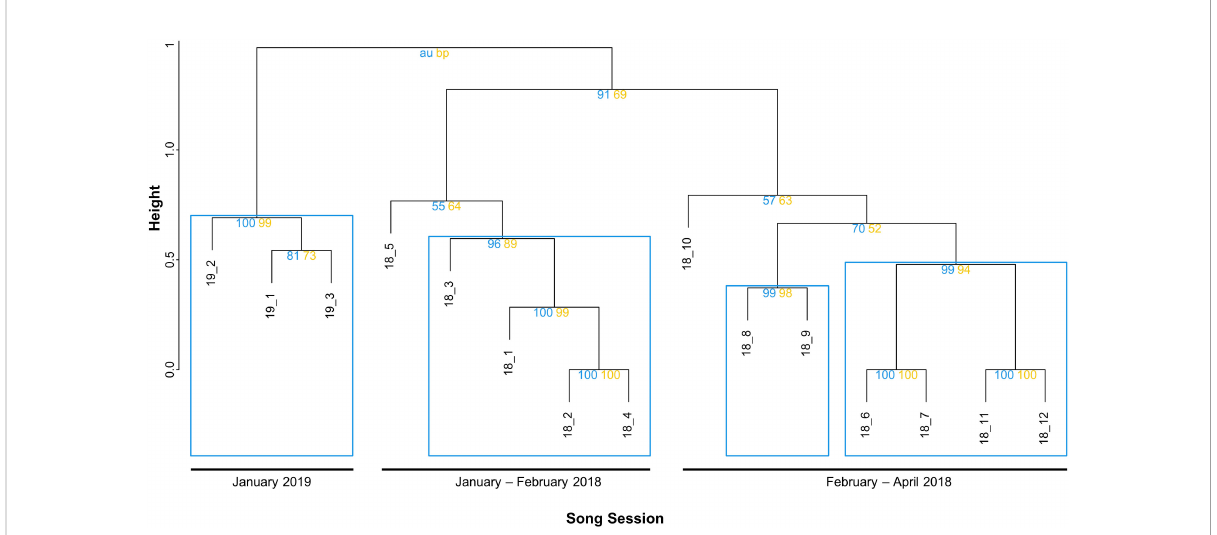
FIGURE 5 Dendrogram of bootstrapped (1000) LSI of average-linkage hierarchical clustered set medians per song cycle (sequence of themes). The Cophenetic Correlation Coef fi cient (CCC)=0.93, indicating a good representation of the structure within the data. Numbers represent multiscale bootstrap resampling (AU, blue left) and normal bootstrap probability (BP, yellow right) which is considered signi fi cant if AU p>95% and BP p>70%. Lower values indicate variability in their division whereas branches with high AU values represent stable divisions. Stable and highly supported clusters were marked using dashed rectangles at the highest